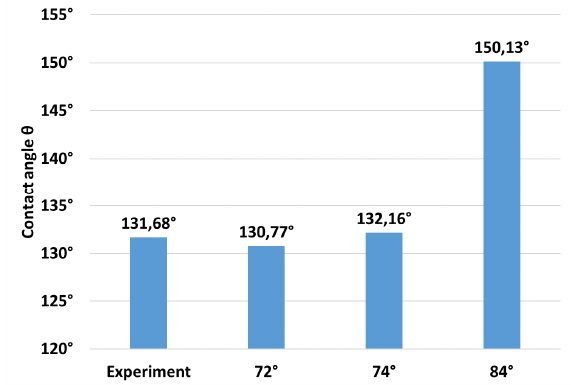
Fig. 6. Contact angle depending on θ 0 – structure 3MR50P25 , θ 0 = {72°, 74° and 84°}.